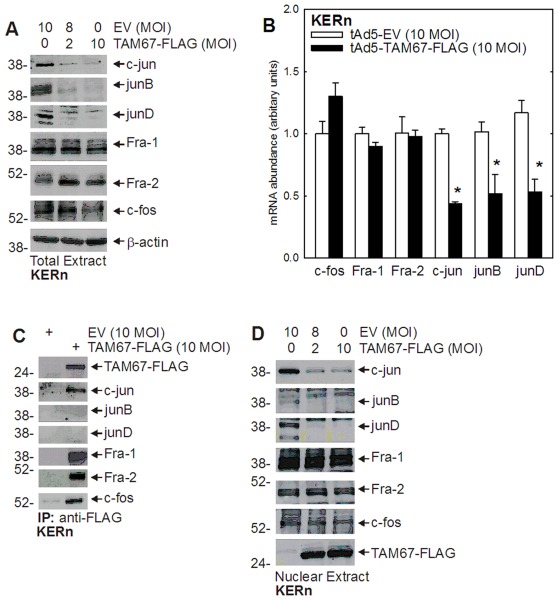
Impact of TAM67-FLAG on AP1 factors.Keratinocytes were infected with empty (EV) or TAM67-FLAG encoding adenovirus and after 24 h cells were harvested and extracts prepared. A Total extracts were electrophoresed for immunoblot detection of the indicated proteins. B TAM67-FLAG suppresses jun factor mRNA level. At 24 h post-infection with EV or TAM67-FLAG encoding virus, mRNA was prepared for detection by quantitative PCR. The bars are mean ± SD and the asterisks indicate a significant reduction (p<0.005, n = 3). C Total extract (200 µg) was immunoprecipitated with anti-FLAG and the immunoprecipitate was electrophoresed for immunoblot to detect the indicated jun and fos proteins. D Nuclear extract was prepared and the level of each indicated protein was measured by immunoblot. Similar results were observed in three experiments.